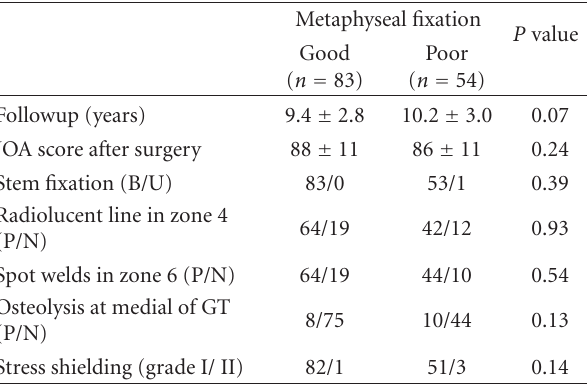
Table 1: The metaphyseal fit and outcomes of THA. Metaphyseal